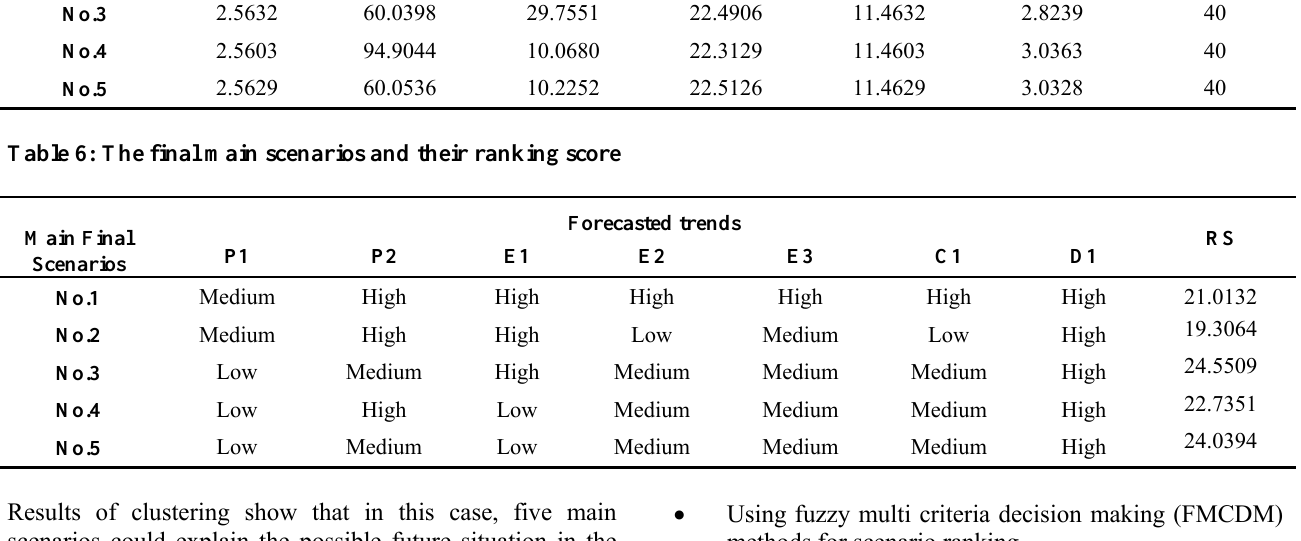
Table 5: Cluster centres Cluster centres